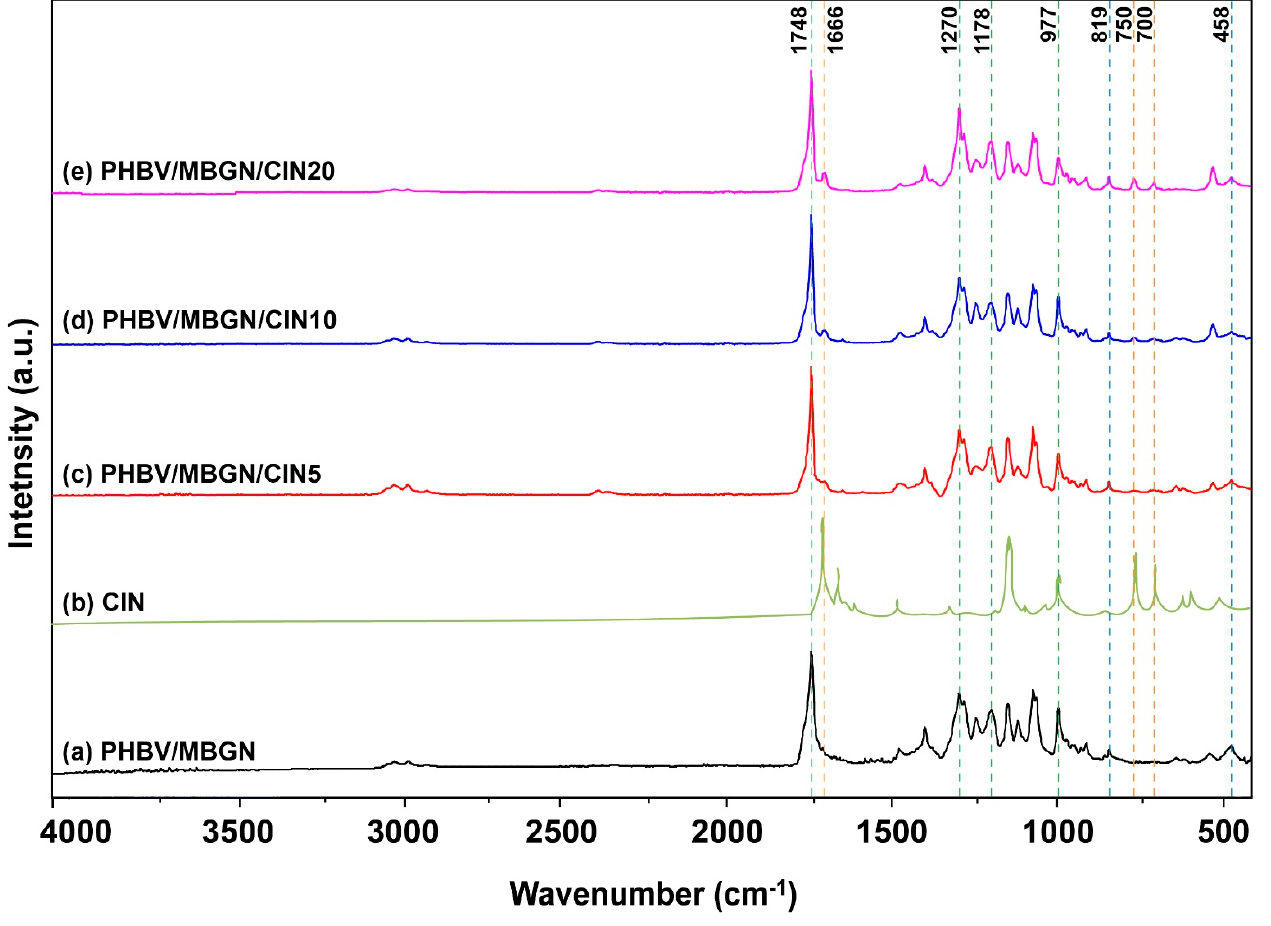
Figure 2. FTIR spectra of ( a ) PHBV/MBGN; ( b ) CIN; ( c ) PHBV/MBGN/CIN5; ( d ) PHBV/MBGN/CIN10, and ( e ) PHBV/MBGN/CIN20 in the range of 4000–400 cm –1 . The relevant peaks are discussed in the text.